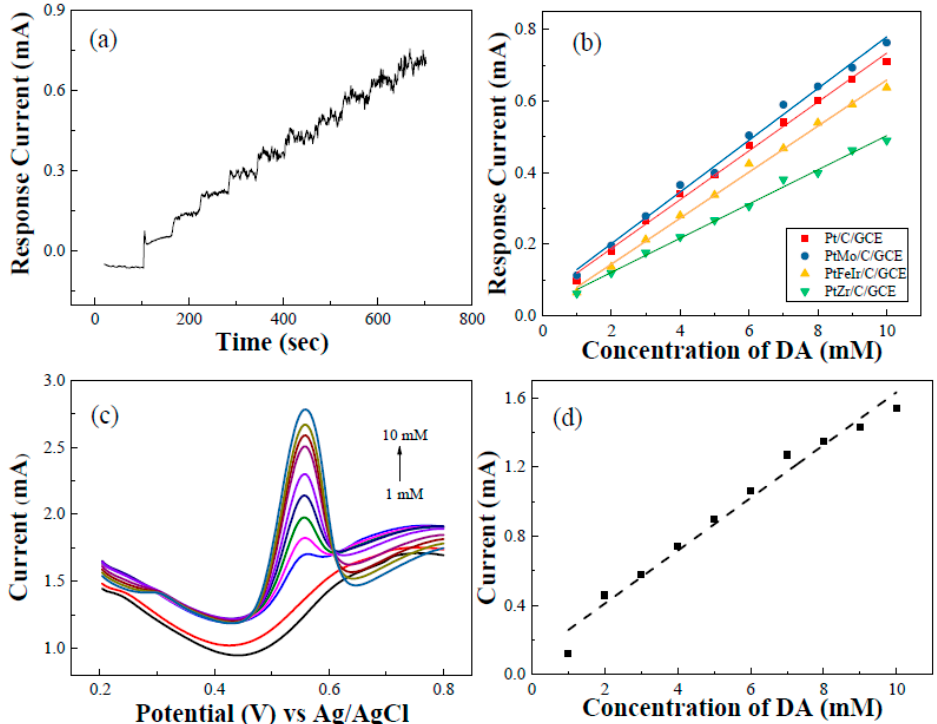
Figure 7. ( a ) Amperometric response for Pt-Mo/C/GCE for concentrations of DA from 1 to 10 mM at an applied potential of 0.6 V vs. Ag/AgCl; ( b ) calibration curves for Pt/C/GCE, Pt-Mo/C/GCE, Pt-Zr/C/GCE, and Pt-Fe-Ir/C/GCE for concentrations of DA from 1 to 10 mM at an applied potential of 0.6 V vs. Ag/AgCl; ( c ) DPV curves for Pt-Mo/C/GCE for concentrations of DA from 1 to 10 mM; and ( d ) calibration curve for Pt-Mo/C/GCE from ( c ).